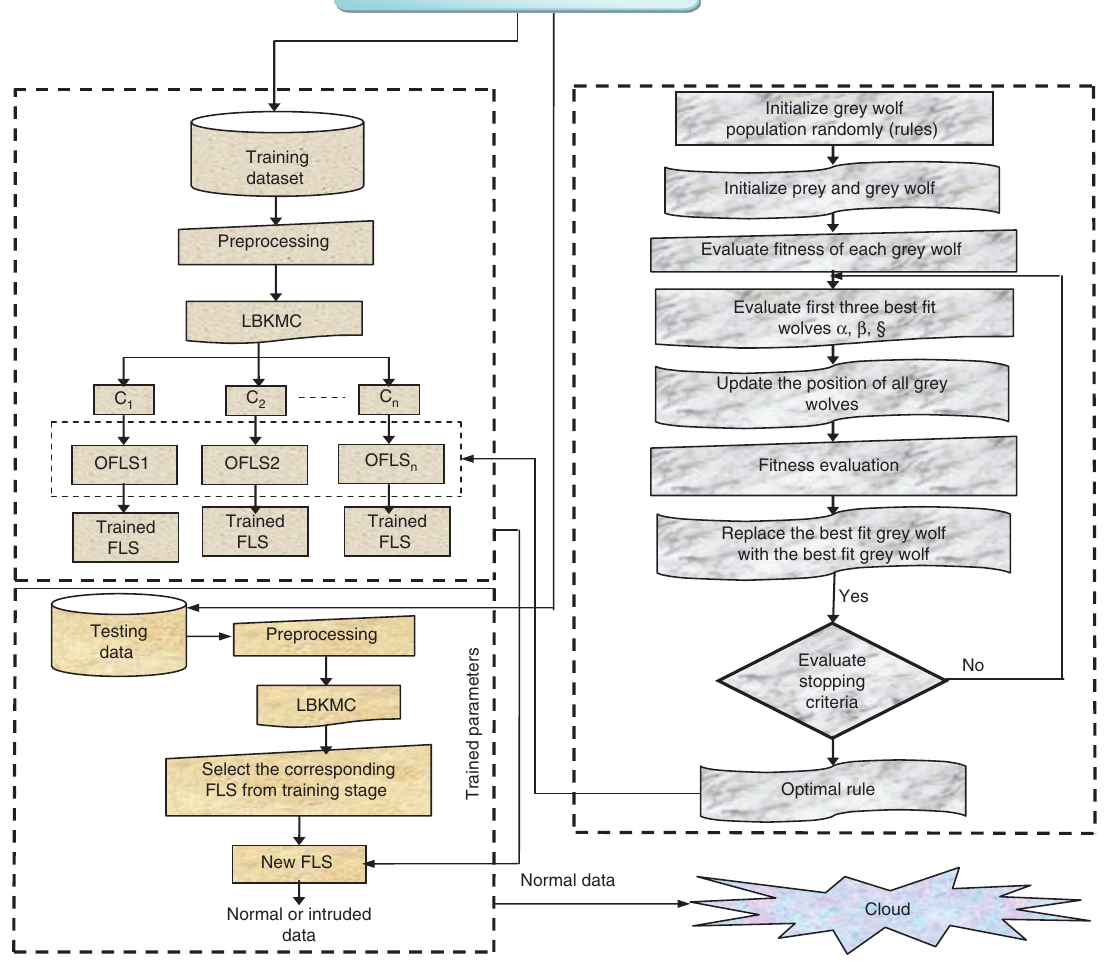
Figure 1: Overall Diagram of a Proposed Intrusion Detection